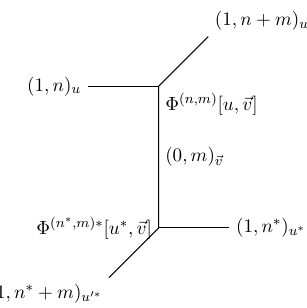
Figure 6 . T operator for U( m ) instanton partition U( m )